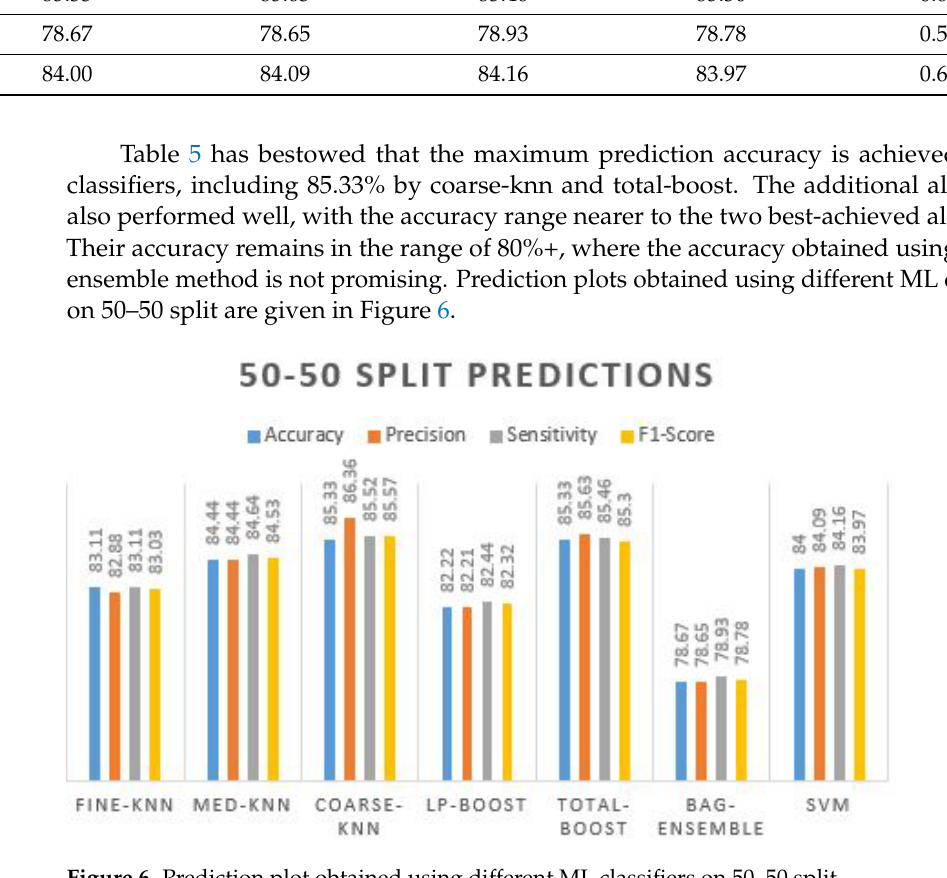
Figure 6. Prediction plot obtained using different ML classifiers on 50–50